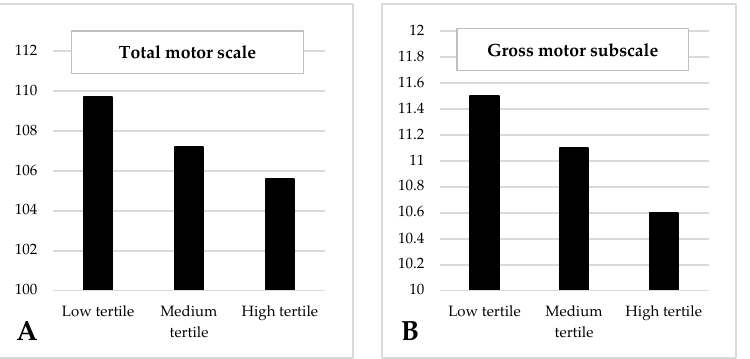
Figure 4. Total motor scale ( A ) and gross motor subscale ( B ) for tertile groups of isobutyric acid at the first trimester. ( A ) Low-tertile mean score = 109.9 (SD = 10.2), medium-tertile mean score = 107.3 (SD = 13.6), high-tertile mean score = 105.4 (SD = 10.7). Model F = 3.722; p = 0.025. ( B ) Low-tertile mean score = 11.5 (SD = 2.3), medium-tertile mean score = 11.1 (SD = 2.3), high-tertile mean score = 10.6 (SD = 2.2). Model F = 4.824; p = 0.009. Models adjusted for mother’s age, family’s socioeconomic status, first trimester state anxiety, smoking during pregnancy, first trimester quality of diet, first trimester BMI, mode of delivery, gestational age at birth, infant’s birth weight, infant’s sex, breast- feeding at 40 days postpartum, and bonding difficulties.